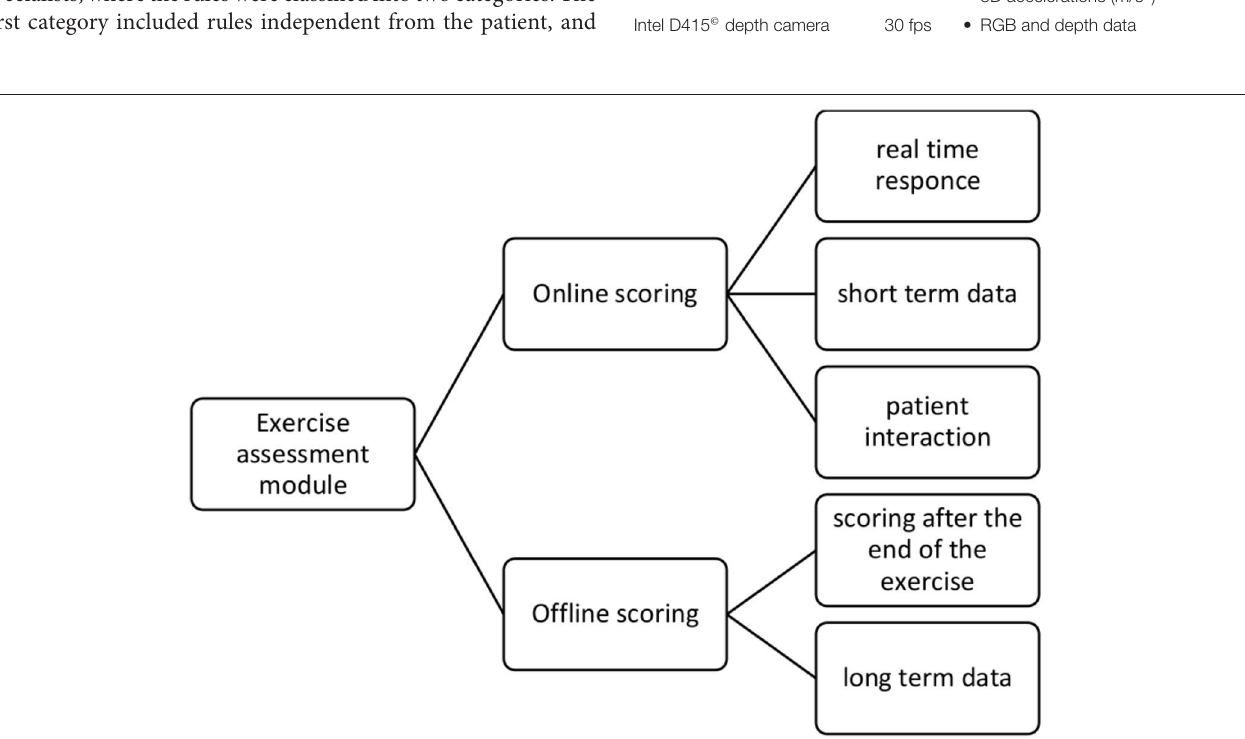
FIGURE 6 | Proposed methodology for exercise